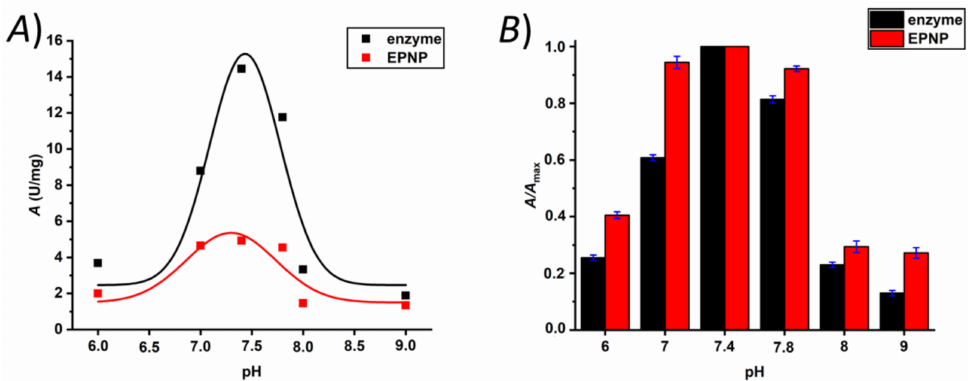
Figure 6. Enzymatic activity ( A ) and the relative activity ( B ) of α -chymotrypsin (black) and the enzyme–polymer nanoparti- cle (red) as a function of